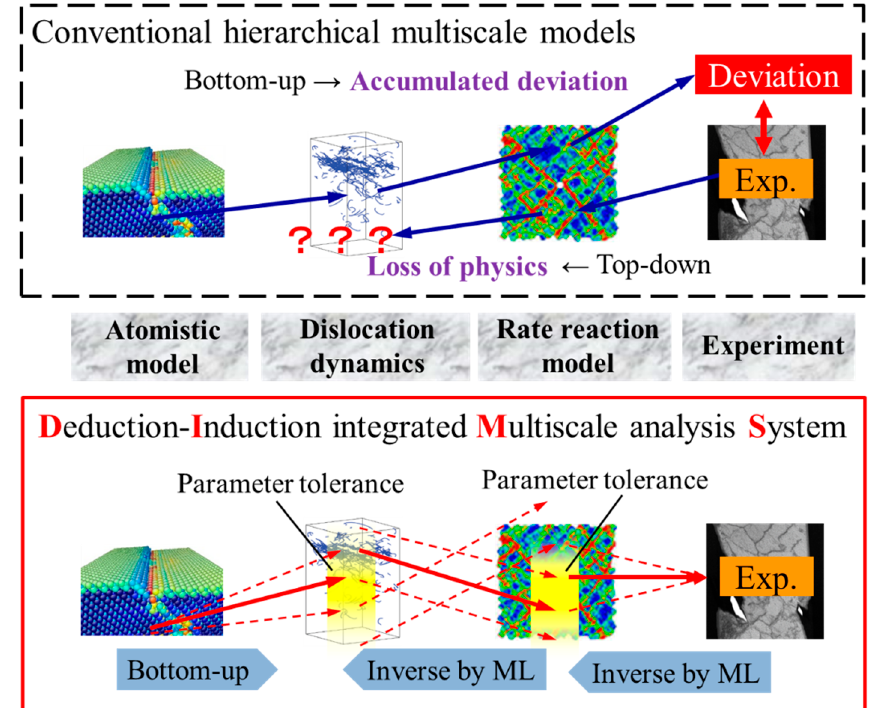
Figure 6. Schematic explaining the concept of suggested integration of deduction–induction ap- proaches compared with conventional hierarchical multiscale models.